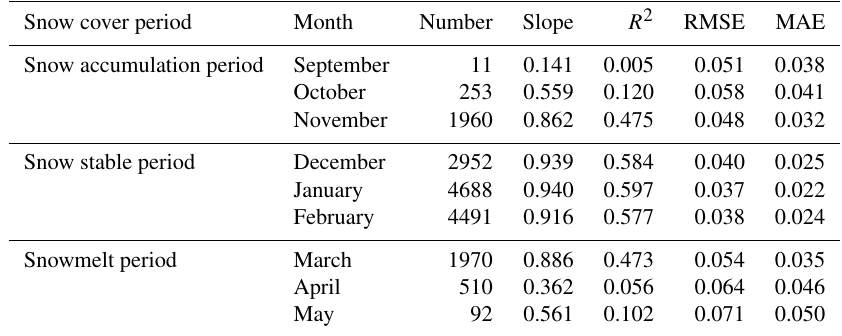
Table 1. Accuracies of snow density estimation in different months. Snow cover